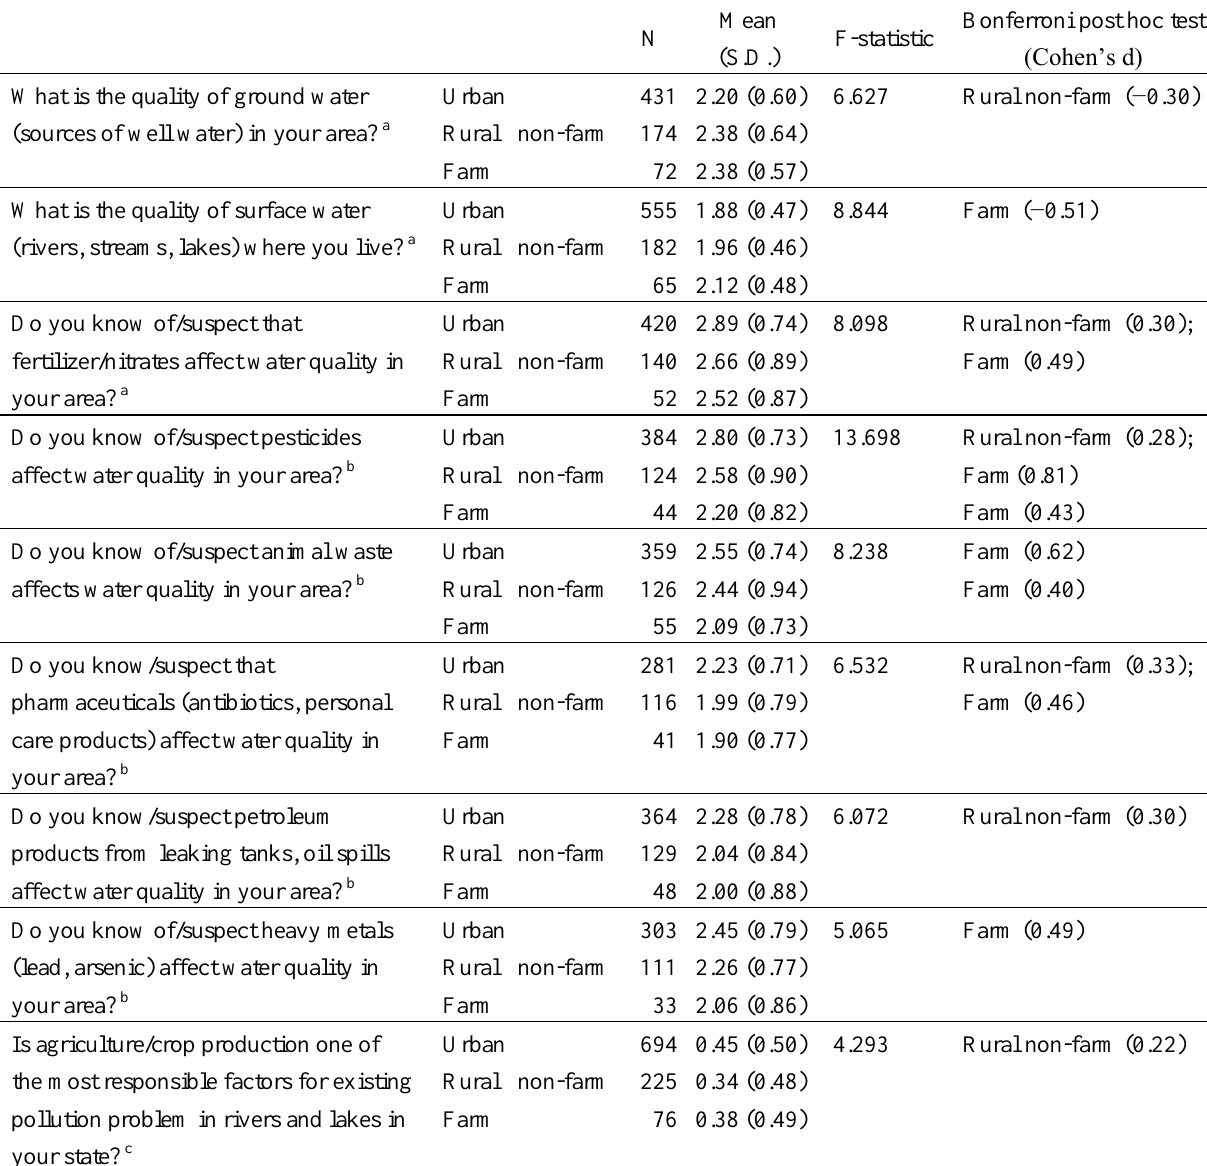
Table 3. Comparisons of beliefs about water quality and perceptions of causality among urban, rural non-farm and